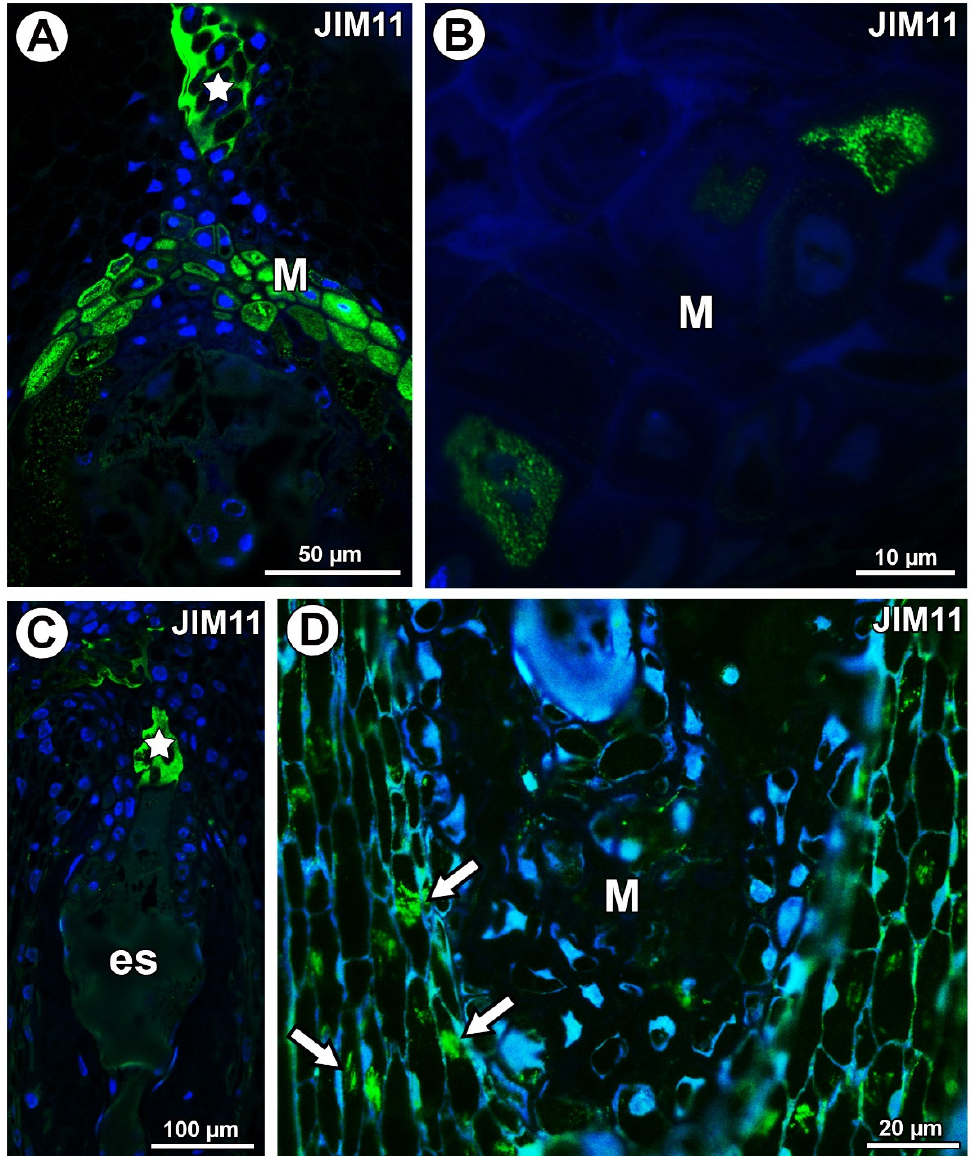
Figure 9. Extensin (labeled with JIM11) detection. ( A ) Section through the young seed of Taraxacum officinale ; note the occurrence of extensins in the transmitting tissue (star) and mucilage cells in the micropylar pole (M). ( B ) Extensin detection in cytoplasm of some mucilage cells (M) of T. officinale young seed. ( C ) Section through the ovule of Pilosella officinarum ; note the occurrence of extensins in the transmitting tissue (star); embryo sac (es). ( D ) Association between extensions and calcium oxalate crystals (arrows); note the mucilage cells (M) in P. officinarum ovule. In Taraxacum and Pilosella , extensins labeled with JIM20 occurred in the ovule transmitting tissue (Figure 10A) and in the pistil transmitting tissue (Figure 10A,B). Extensins labeled with JIM20 were only associated with calcium oxalate crystals in Pilosella (Figure 10C). They were not recorded in the mucilage cells (Figure 10A,B) for both species.